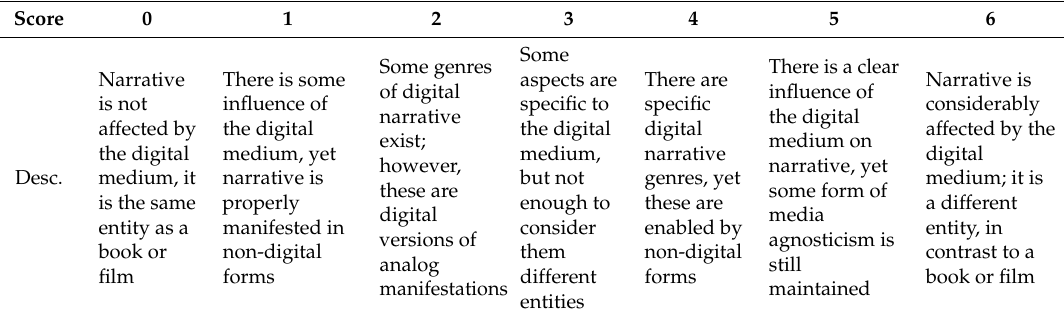
Table 1. Scale for media specificity.